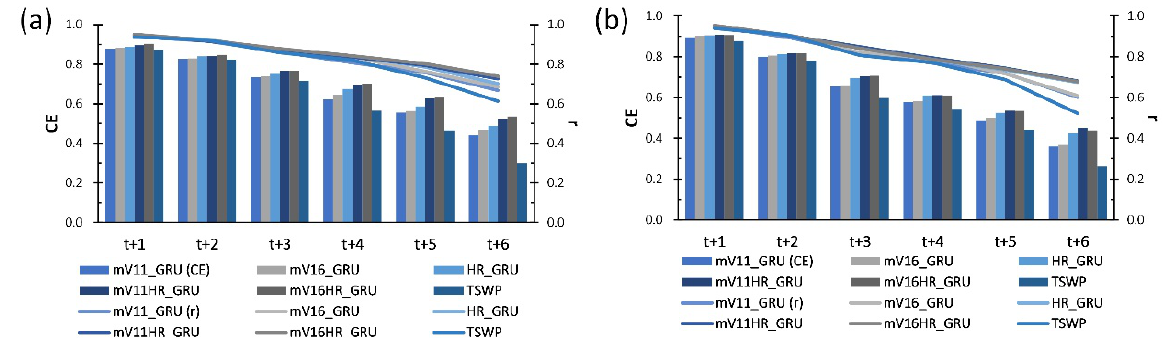
Figure 11. CE and r of data from the ( a ) Longdong and ( b ) Guishandao buoys.